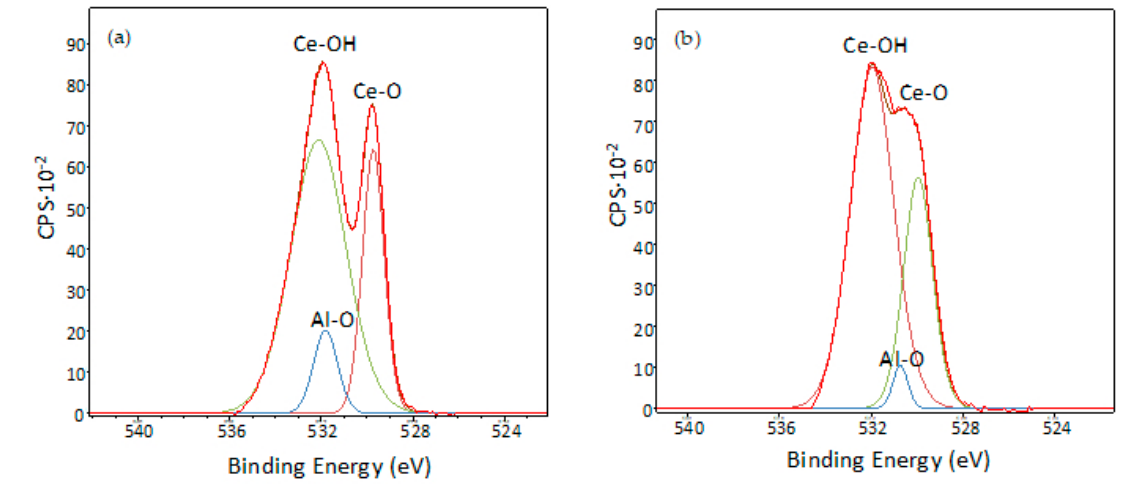
Figure 15. XPS spectra of O1s. ( a ) CeCC-1, ( b ) CeCC-2.